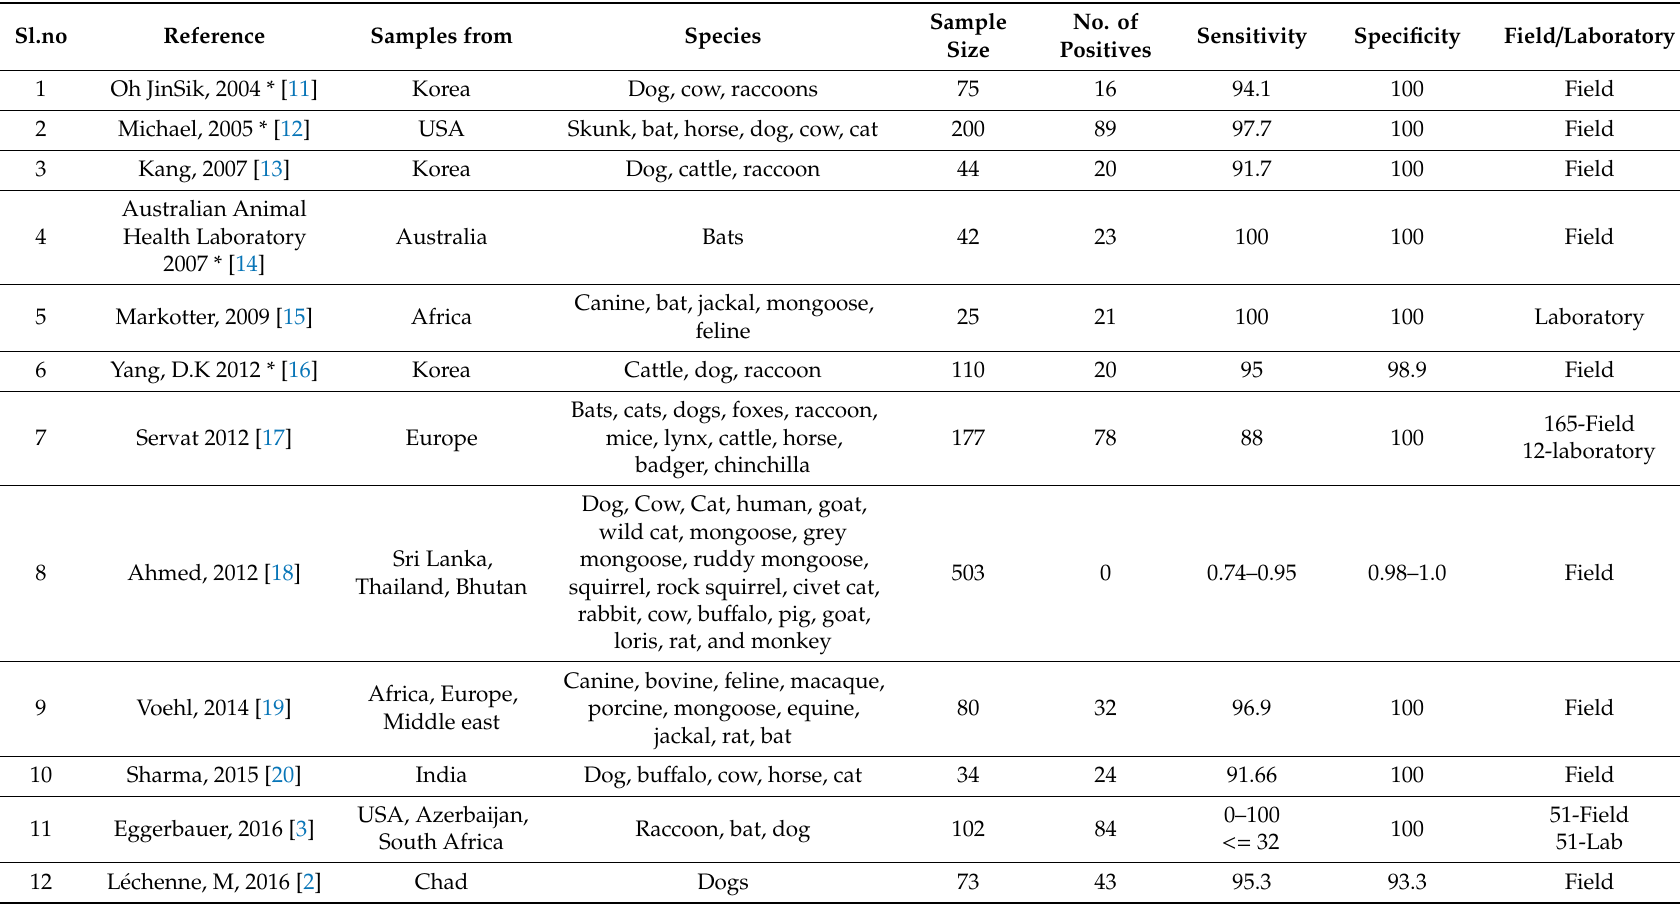
Table 1. Publications on the sensitivity and specificity of Anigen Rapid Rabies Ag Test Kit,